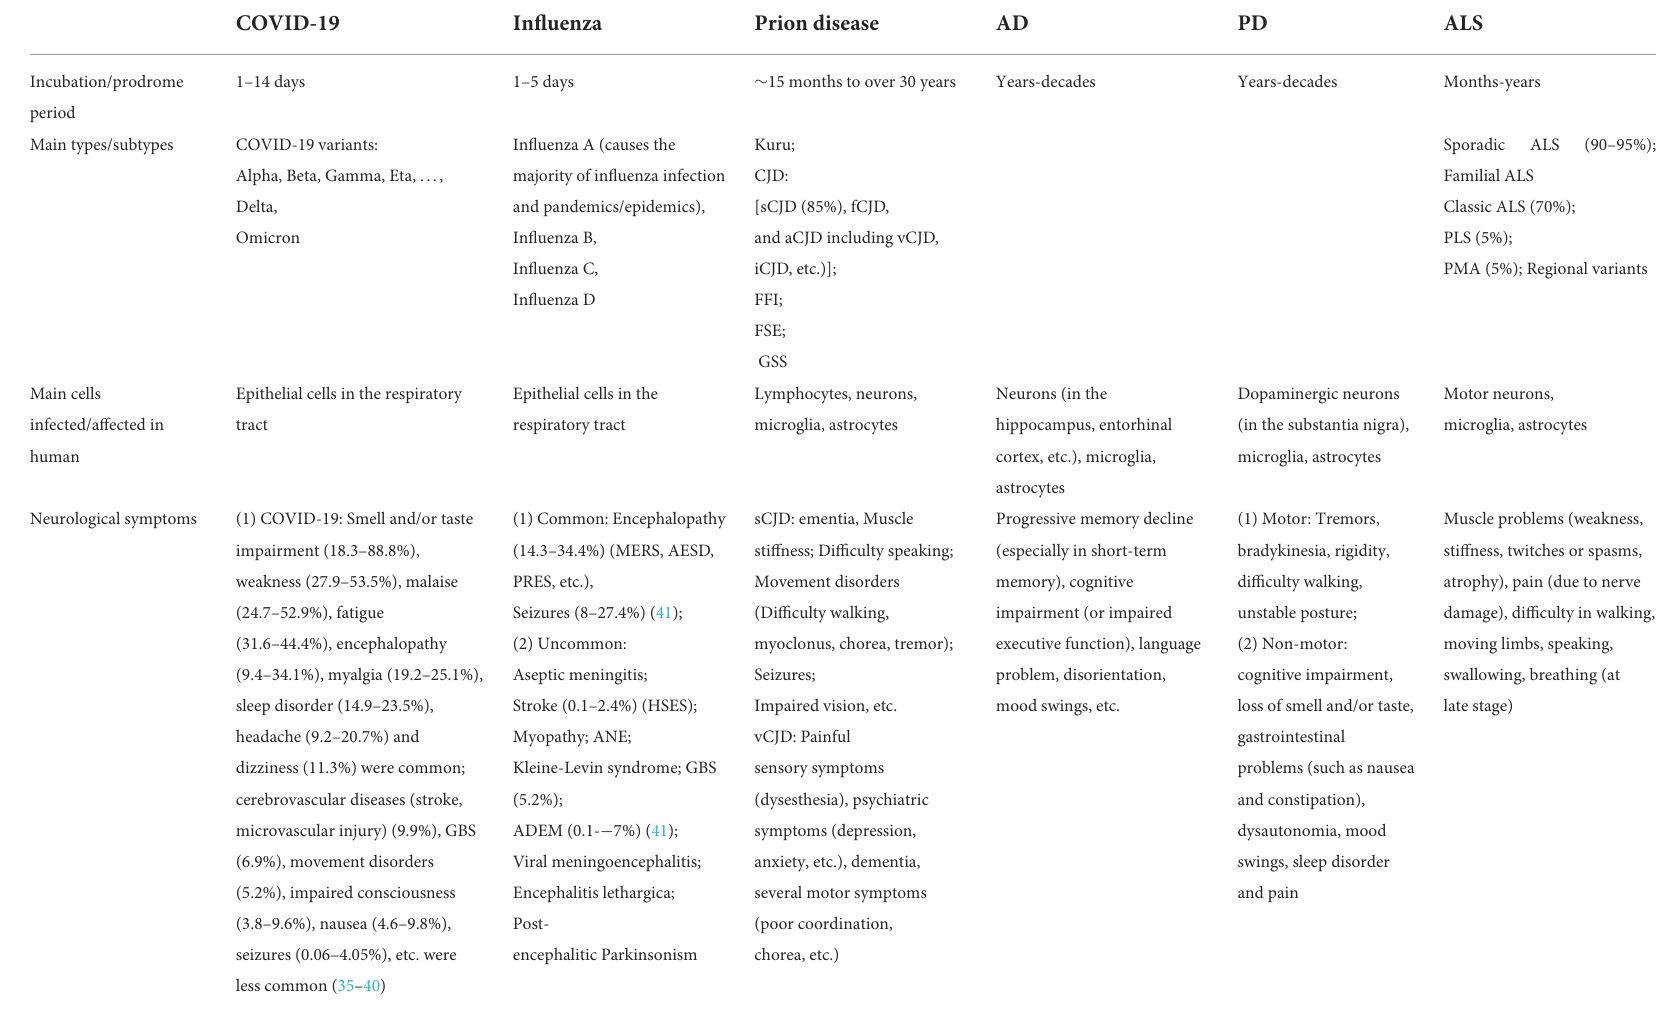
TABLE 1 Main features (including neurological symptoms) of infectious diseases (COVID-19, influenza, and prion disease), and neurodegenerative disorders (Alzheimer’s Disease, Parkinson’s Disease, and Amyotrophic Lateral